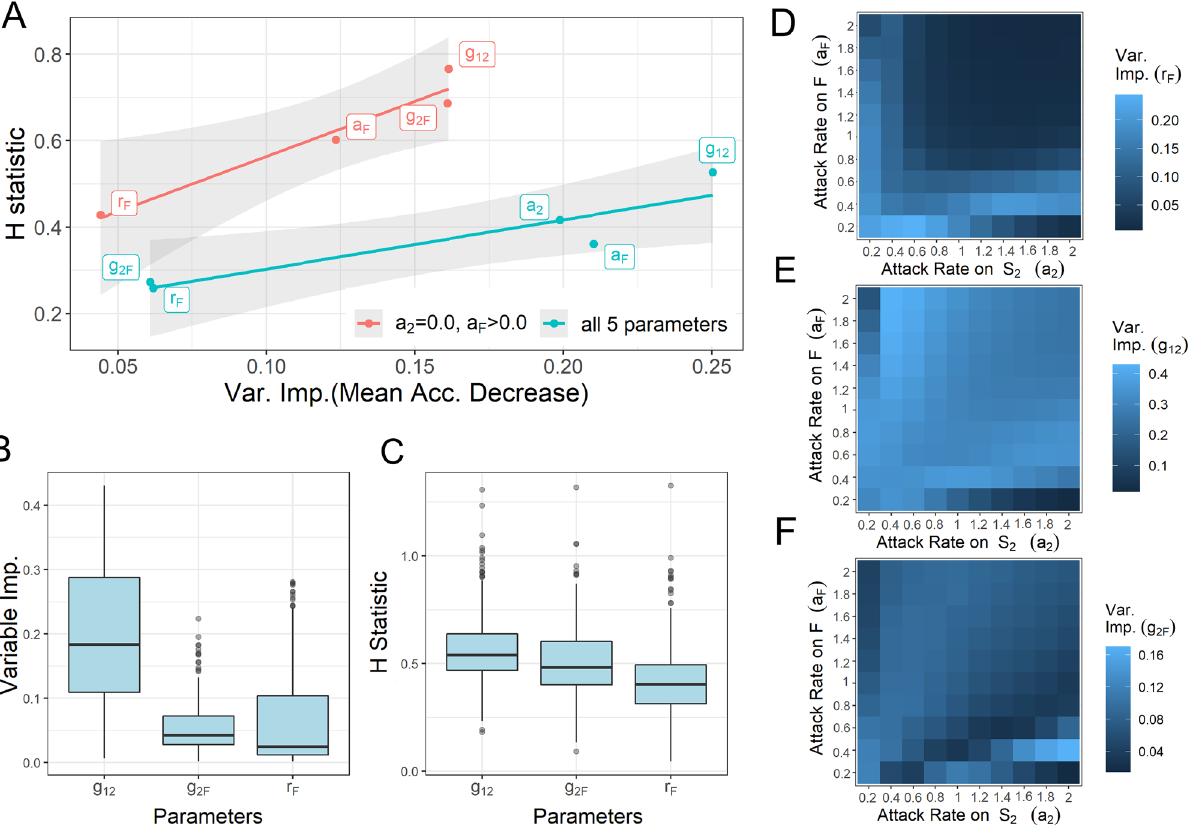
Figure 2. Random forest output overview. ( A ) Relationship between Variable Importance and interactivity (H-statistic) of parameters in Random Forest output. Blue line: RF model across all five parameters, AUC:0.998 ( α g 1 = α g 2 = α F = 0.1; h 2 = h F = 0.5). Red line: RF model with single stage herbivory ( a 2 = 0); AUC = 0.984 ( α g 1 = α g 2 = α F = 0.1; h 2 = h F =1). Shaded regions represent standard error. ( B , C ) Box and whisker plots detailing range of Variable Importance ( B ) and H-statistic ( C ) for each demographic rate in random forests run with set attack rates where a 2 and a F vary between 0.2 and 2.0 ( α g 1 = α g 2 = α F = 0.1; h 2 = h F = 0.5). Boxes represent the interquartile range with the horizontal line showing the median, the lower box showing the 25 percentile, and the upper box showing the 75 percentile. Upper and lower lines extending from the boxes show the most extreme values within 1.5 times the 75th and 25th percentile respectively. Outliers are shown as single dots. ( D – F ) Heatmaps showing changing importance for each demographic rate across different allocations of consumption across plant stages. Here we found consistently but only slightly better performance with mtry =